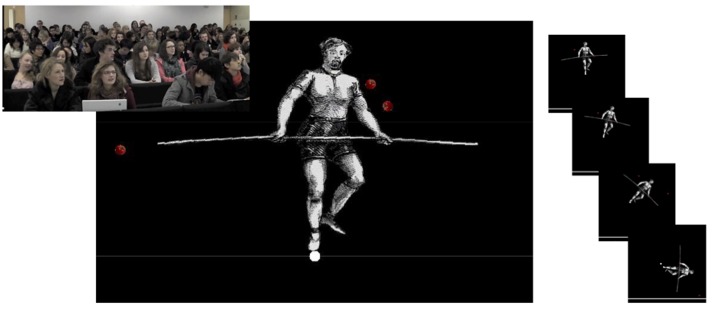
The tightrope game (taken from Richardson et al., 2011).